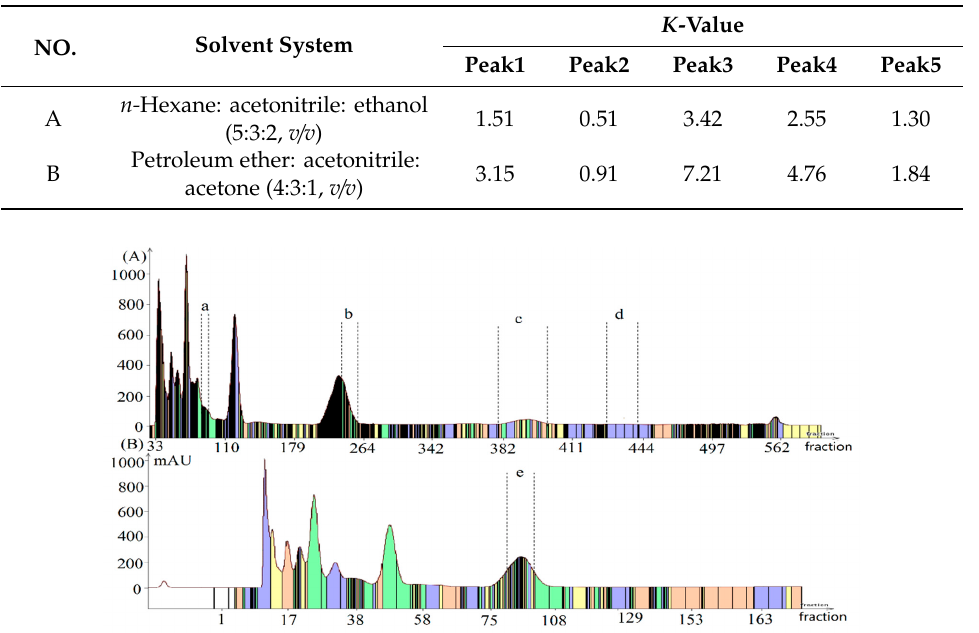
Table 3. The partition coe ffi cient values of compounds.